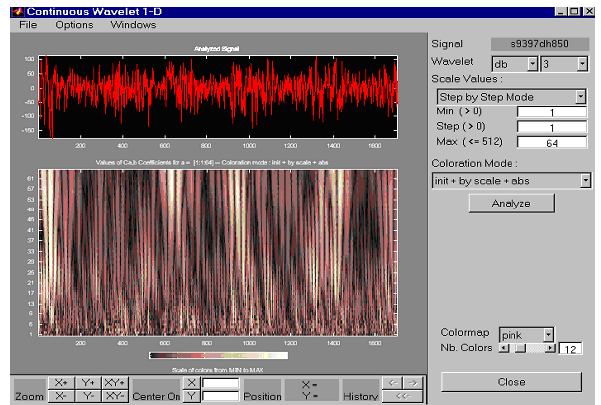
Fig. 1. Continuous wavelet 1-D analysis of the 850-hPa pressure height deviations (Istanbul, 1993–1997).